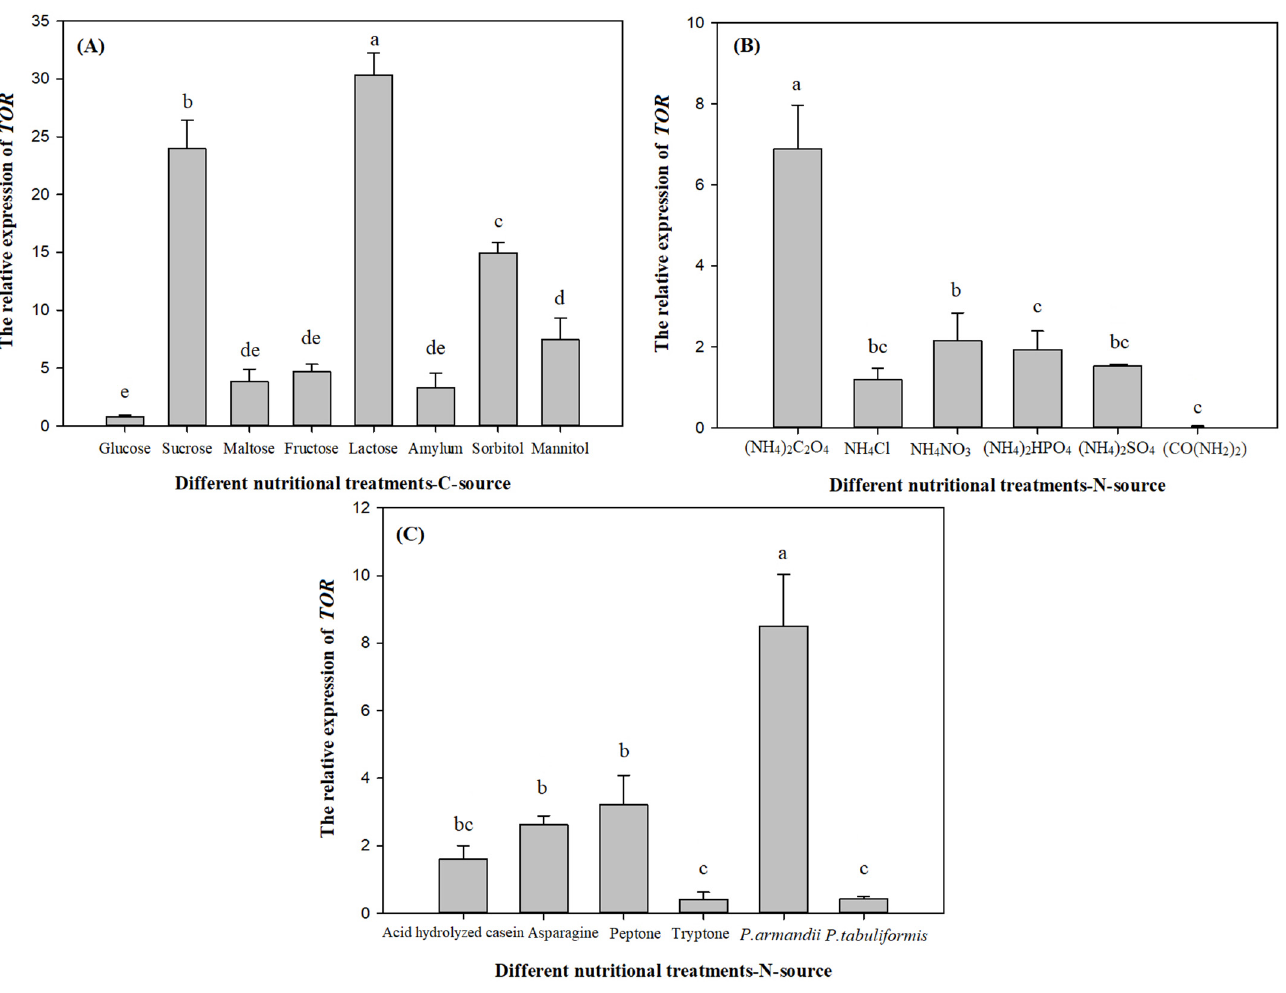
Figure 4. Effects of different nutritional treatments on the relative expression of TOR . The relative expression of TOR is expressed as the mean ± S.E, and the different letters above the bars indicate significant differences ( p < 0.01, Tukey’s HSD test). Eight biological replicates in carbon sources ( A ), 6 biological replicates in inorganic nitrogen sources ( B ), 4 biological replicates in organic nitrogen sources and 2 host nutrition biological replicates ( C ); 5 technical replicates for each biological treat- ment.